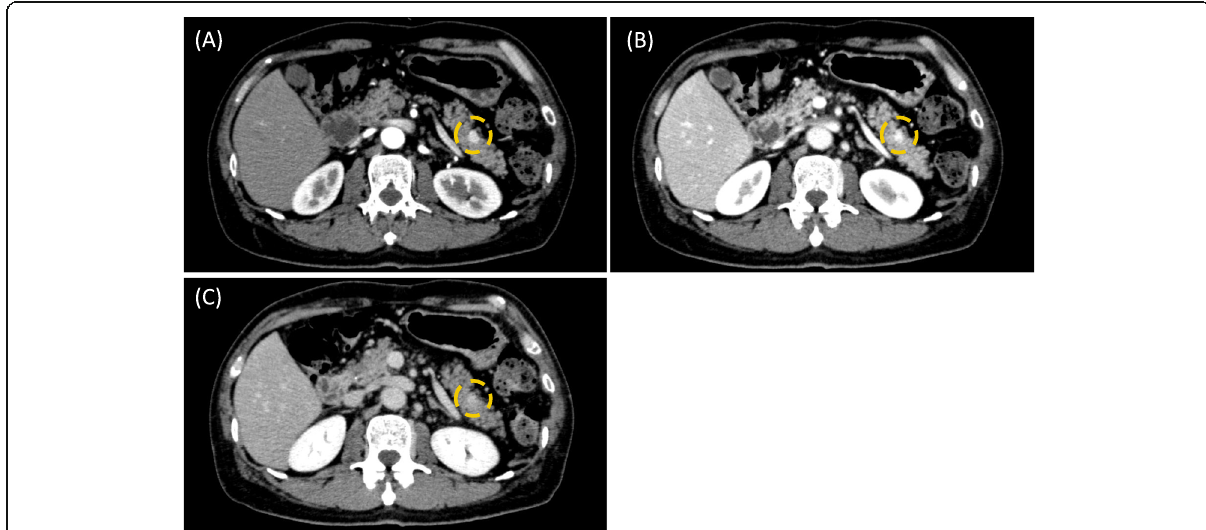
Fig. 2 Computed tomography findings. Contrast-enhanced computed tomography showed an early enhanced nodule about 10 mm in size in the pancreatic tail (circle). An enhancement of the nodule lasted until late phase, although its density was gradually attenuated. a The arterial phase. b The portal phase. c The late phase